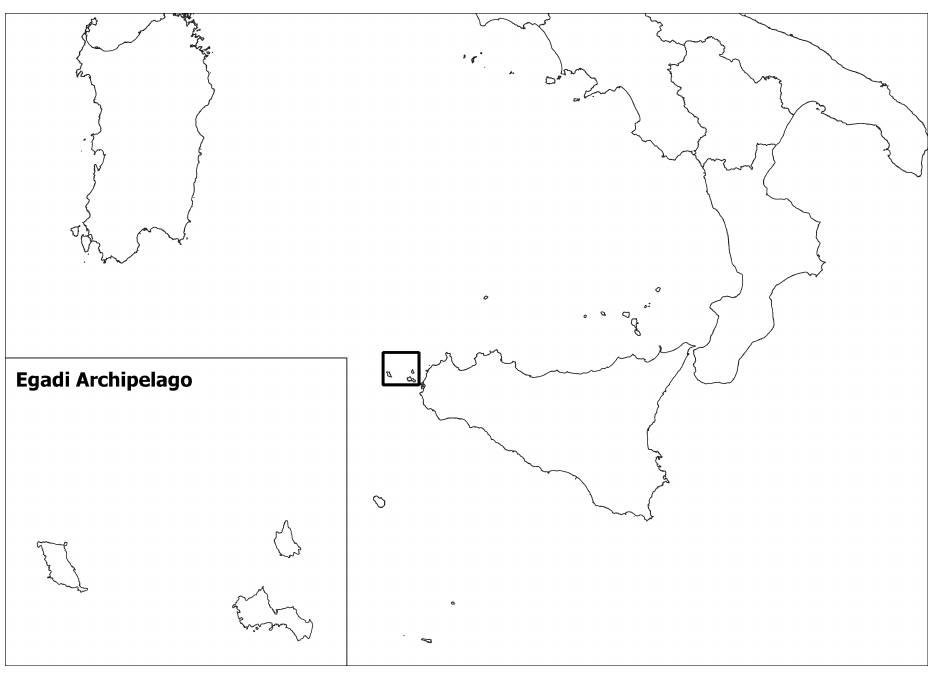
Figure 25. Egadi Archipelago. Table 9. SCI areas on Egadi